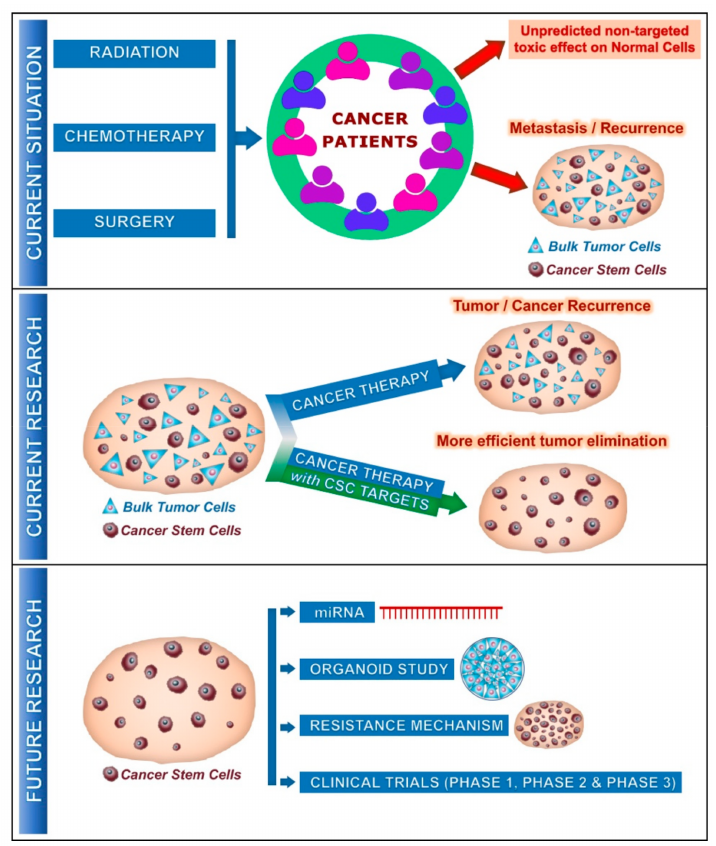
Figure 1. Current and future involvement of cancer stem cells (CSCs) on cancer treatment: Current situation describes the e ff ect of cancer therapy on unpredicted non-targeted e ff ects on normal cells and metastasis / recurrence of cancer after several years due to the presence of CSCs along with tumor cells. Current research reveals that standard cancer therapy with CSC targets provides much more e ffi cient outcomes on the tumor progression with elimination of CSCs. In the future, further studies could be focused on miRNA (microRNA), cancer organoid, resistance mechanism by CSCs and could enter the clinical phases, promising a better outcome for the cancer